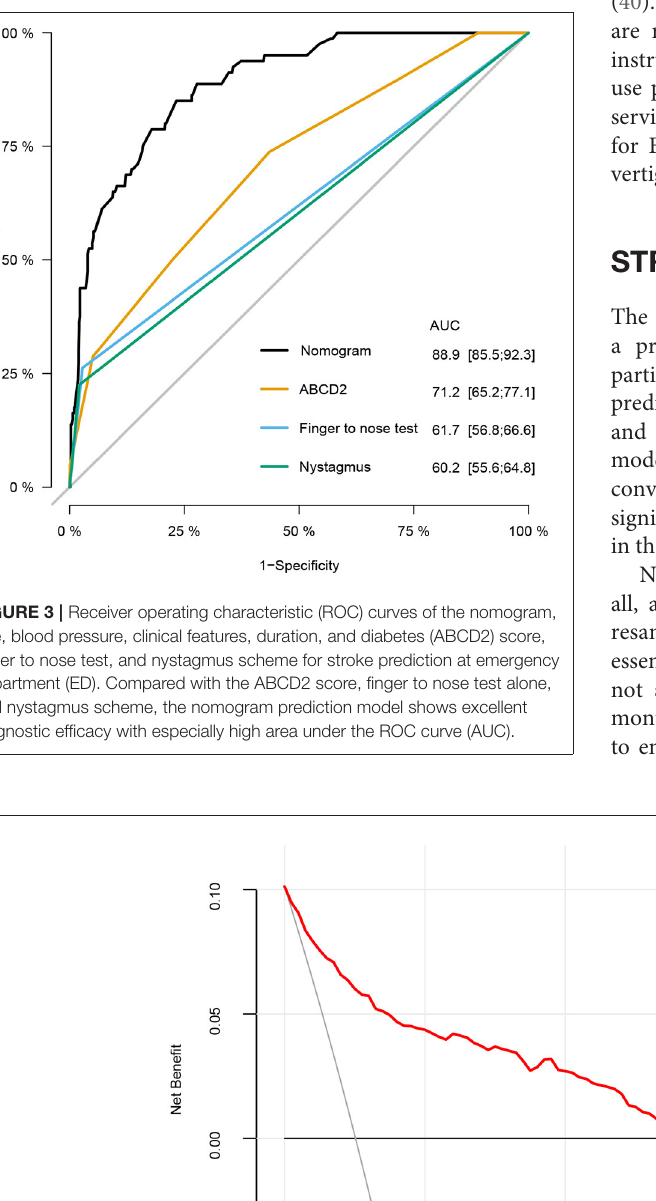
Frontiers in Neurology |